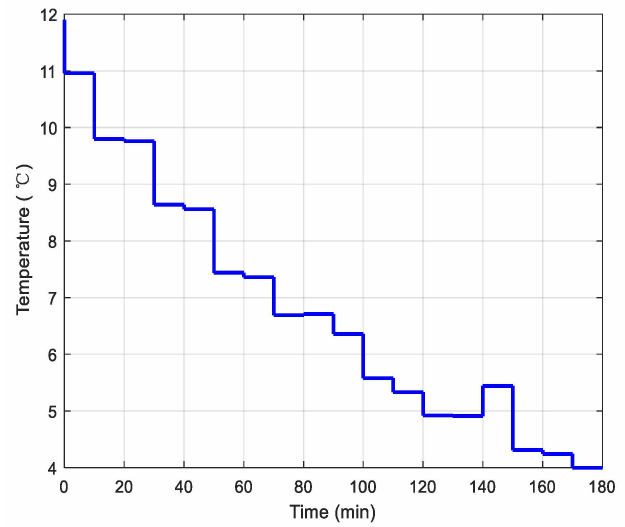
Figure 9. Control input profile for NMPC.